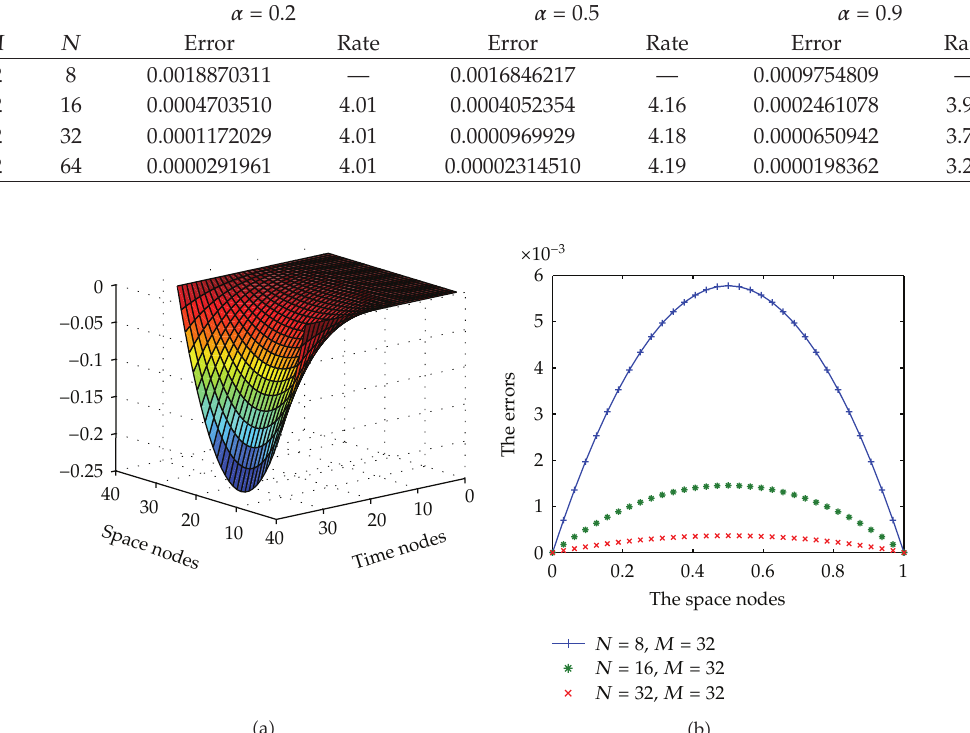
Figure 2: (cid:3) a (cid:5) The approximate solutions of Example 5.2 by the proposed method when N (cid:8) 32, M (cid:8) 32, and α (cid:8) 0 . 5. (cid:3) b (cid:5) The errors for some values of M and N when t (cid:8) 1 and α (cid:8) 0 .